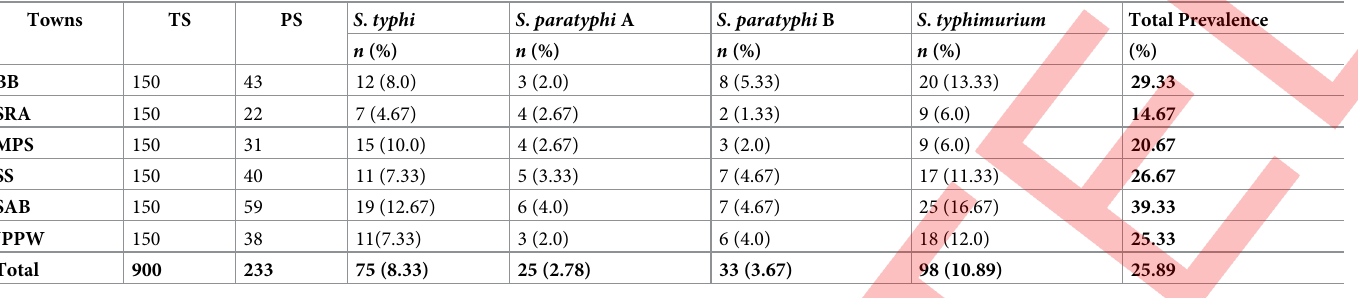
Town; BB: Band Bosan, SRA: Shah Rukne Alam, MPS; Musa Pak Shaheed, SS: Sher Shah, SAB: Shuja Abad, JPPW: Jalal Pur Pir Wala. TS; Total number of samples, PS; Total number of positive sample, n = Number of positive samples of respective spp; χ 2(df = 5, α = 0.05) = 13.3256 at p value = 0.03815 for towns; χ 2(df = 3, α = 0.05) = 6.9249 at p value = 0.0743 for Salmonella spp.